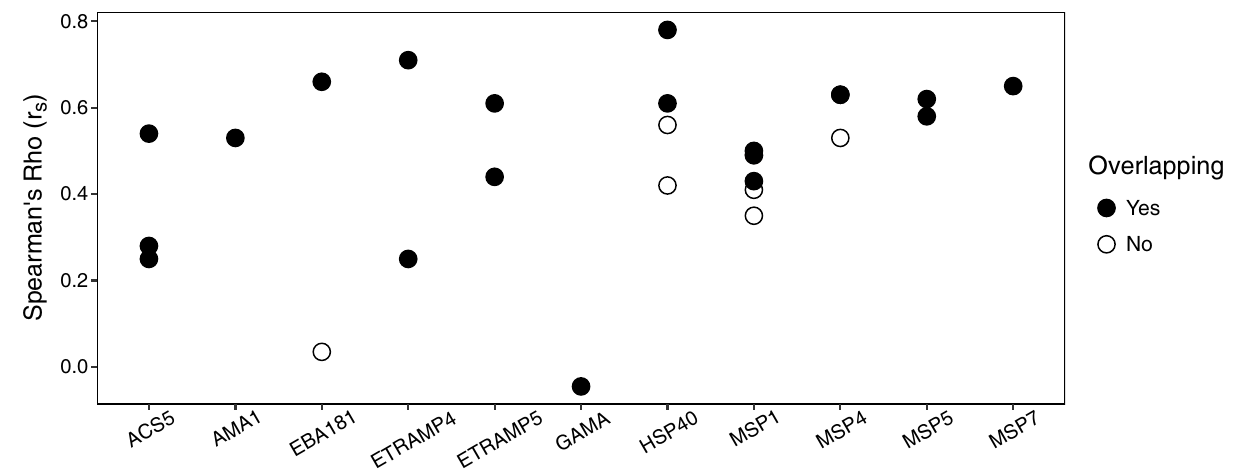
Fig 4. Spearman’s rho correlation coefficients between antigen-matched IVTT and purified proteins. Targets with overlapping amino acid sequences are indicated by closed circles, compared to non-overlapping sequences indicated by open